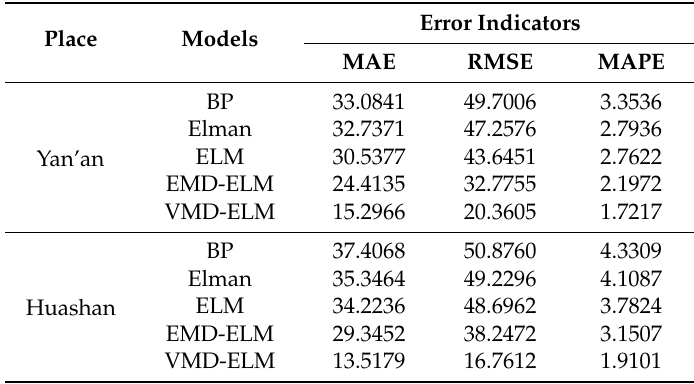
Figure 7. Performance comparison of the prediction results of monthly precipitation for the BP, Elman, ELM, EMD-ELM, and VMD-ELM models. ( a ) Yan’an; ( b ) Huashan. Table 1. Predictive performance comparison of each